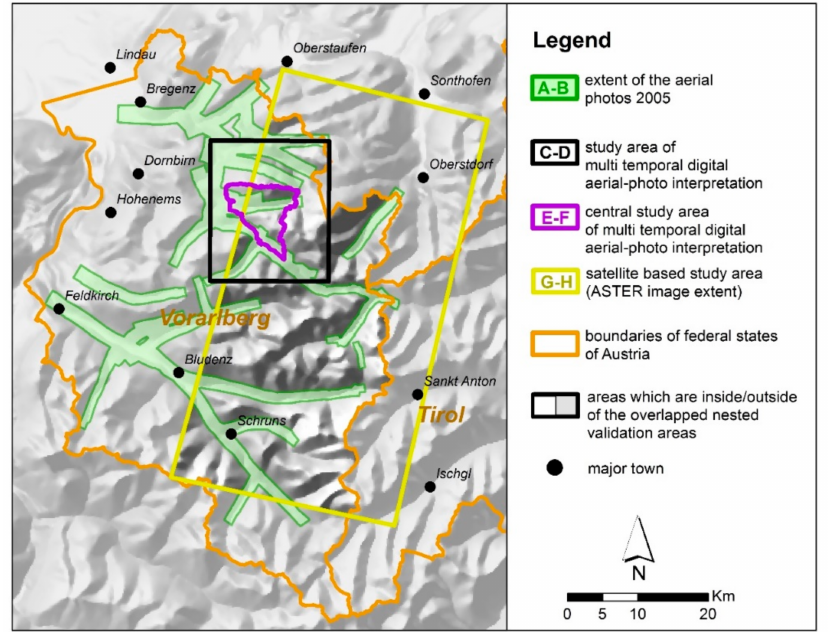
Figure 9. The nested approach showing the subdivision of the four study areas in overlapping zones for methods